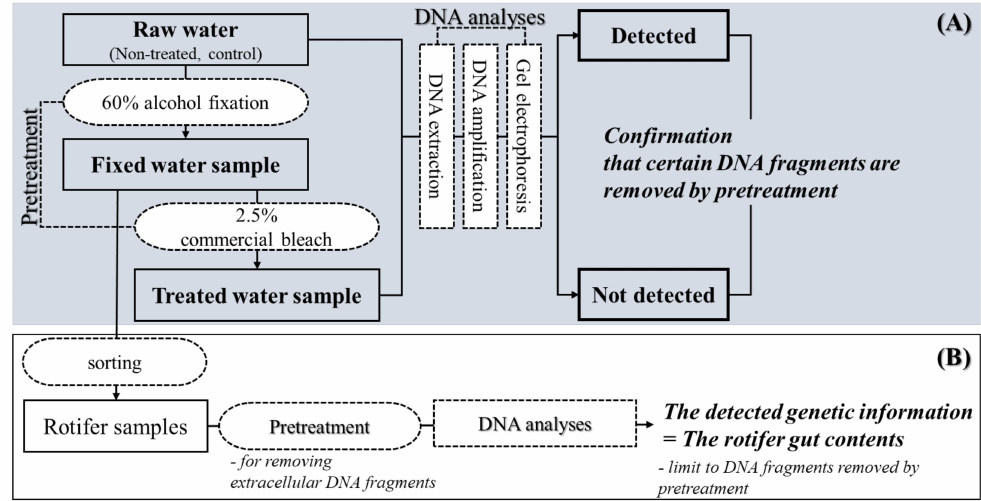
Figure 3. Experimental designs. ( A ) Verifying applicability of pretreatment, ( B ) Application of pretreatment to